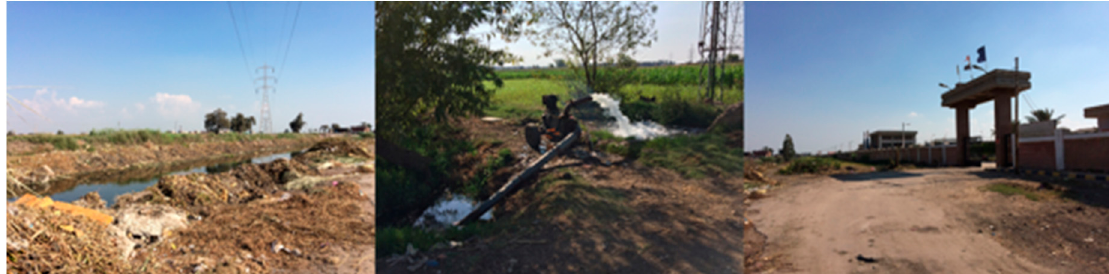
Figure 5. The Edku drainage. Source: Author. Legend: The drainage in front of the WWTP is seriously polluted by different kinds of solid waste, as well as wastewater. It also contains high level of eutrophication ( left ); unofficial reuse of drainage water for irrigation ( middle ); the WWTP adjacent to the drainage ( right ). Location: 31°01 ʹ 09.1 ʺ N 30°27 ʹ 05.8 ʺ E ( left and right ) and 31°05 ʹ 15.4 ʺ N 30°25 ʹ 20.0 ʺ E ( middle ).